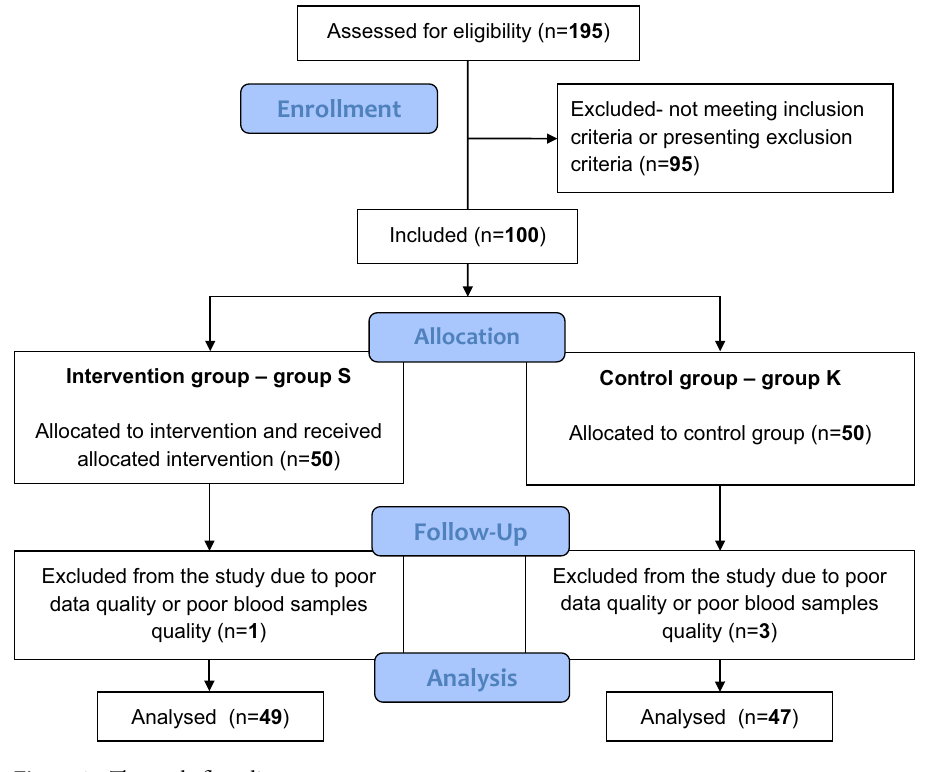
Figure 1. The study flow diagram.